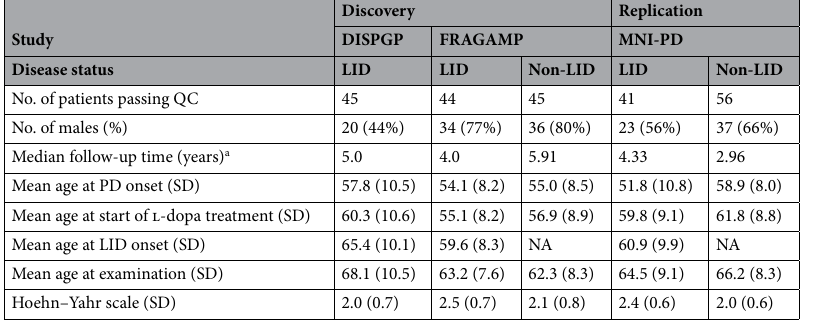
Table 1. Participant characteristics by study. LID levodopa-induced dyskinesia, SD standard deviation. a Follow-up time is defined as the time from the beginning of levodopa treatment until LID onset or until censoring for those patients who did not develop LID. Numbers of patients reported reflect those with exome sequencing data after quality